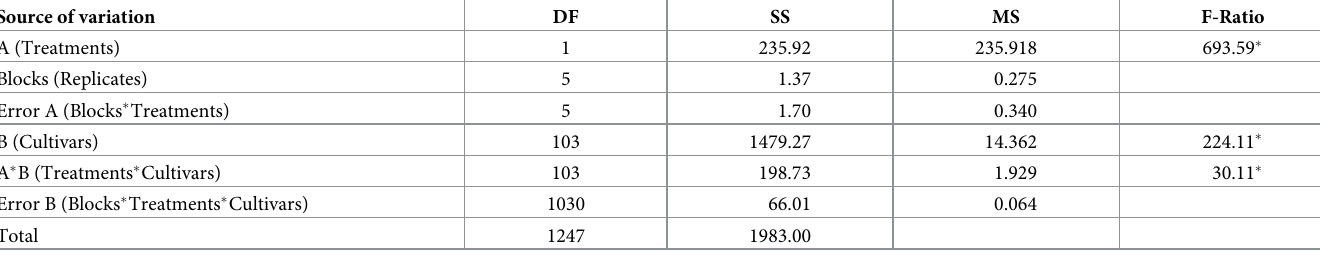
Table 7. Analysis of variance of cultivars and disease treatments for CSS